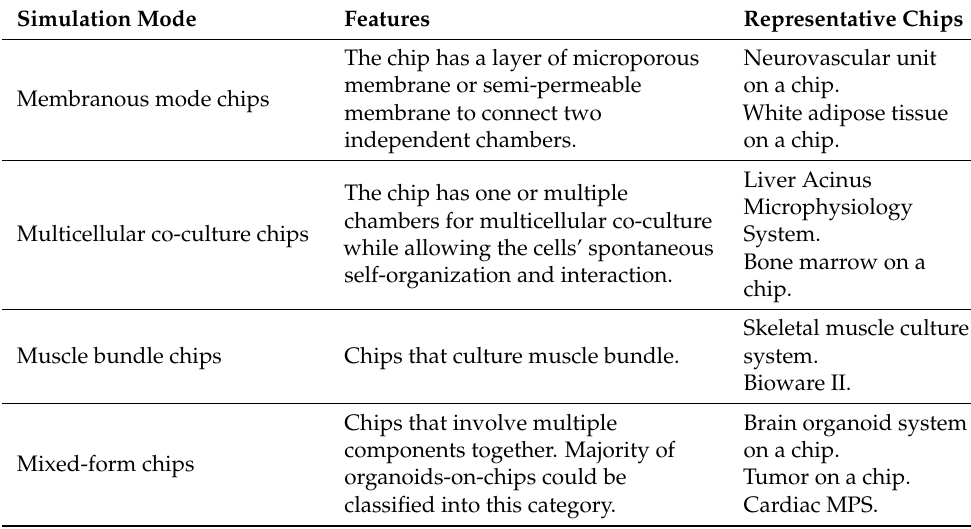
Table 1. Features and representatives of four